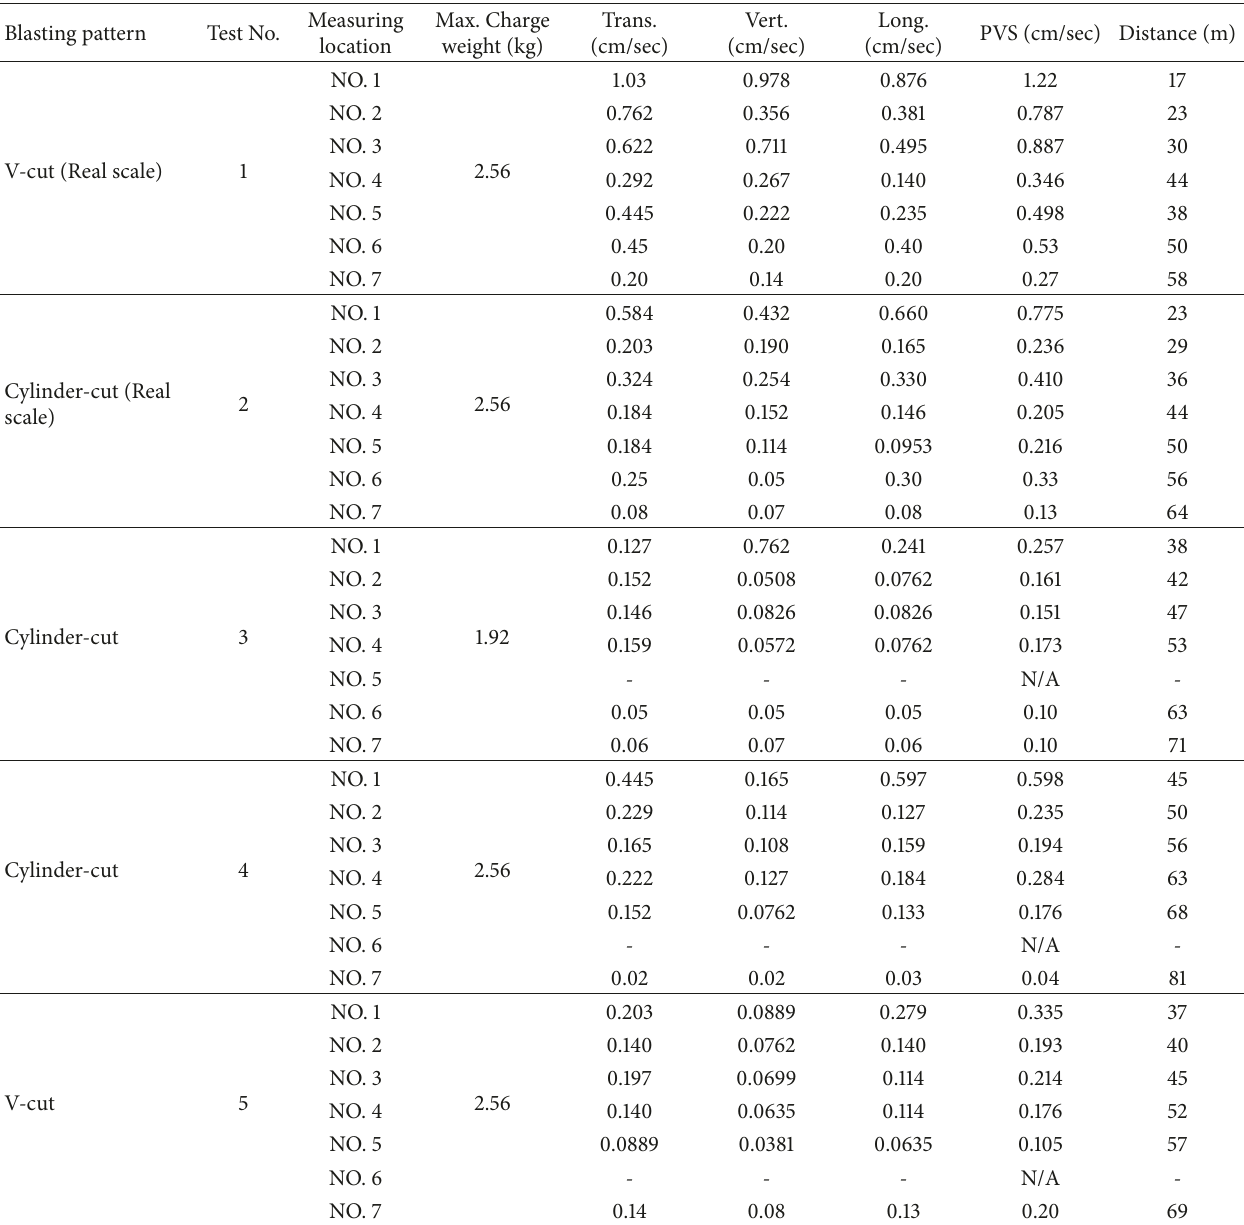
Table 2: Measured results of blasting-induced vibration.